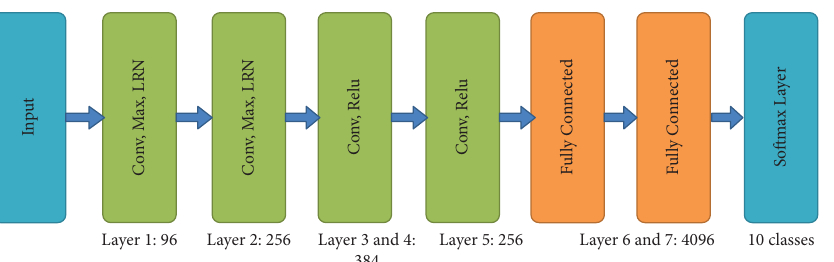
Figure 2: Te architecture of AlexNet.